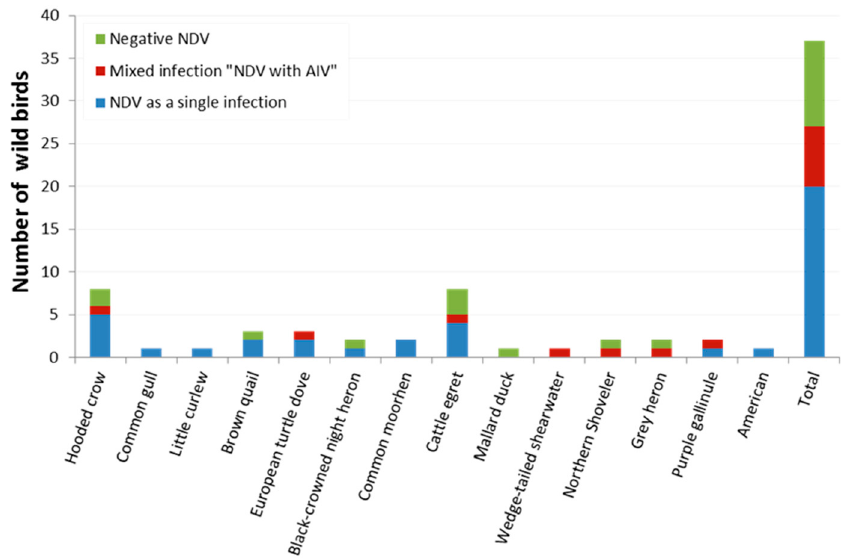
Figure 2. Wild bird breeds in Egypt positive for NDV as single natural infection (detected via NDV F gene-specific RT-PCR, blue bars) or mixed natural infection with NDV and AIV (detected by Flu-M gene-specific RT-PCR, maroon bars). The numbers of birds negative for NDV are indicated as green